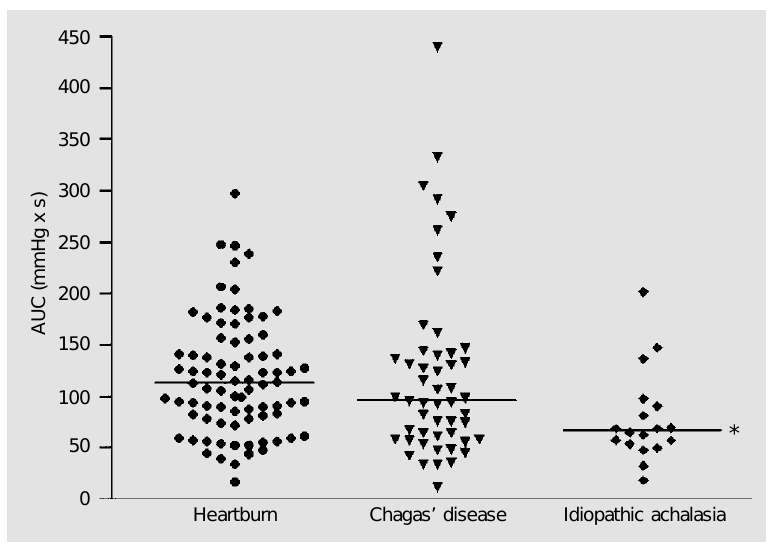
Figure 3. Area under the curve (AUC) of esophageal striated muscle contractions in patients with heartburn, Chagas’ disease or idiopathic achalasia. The horizontal lines indicate the medians. *P = 0.07 compared to heartburn (Tukey-Kramer test).